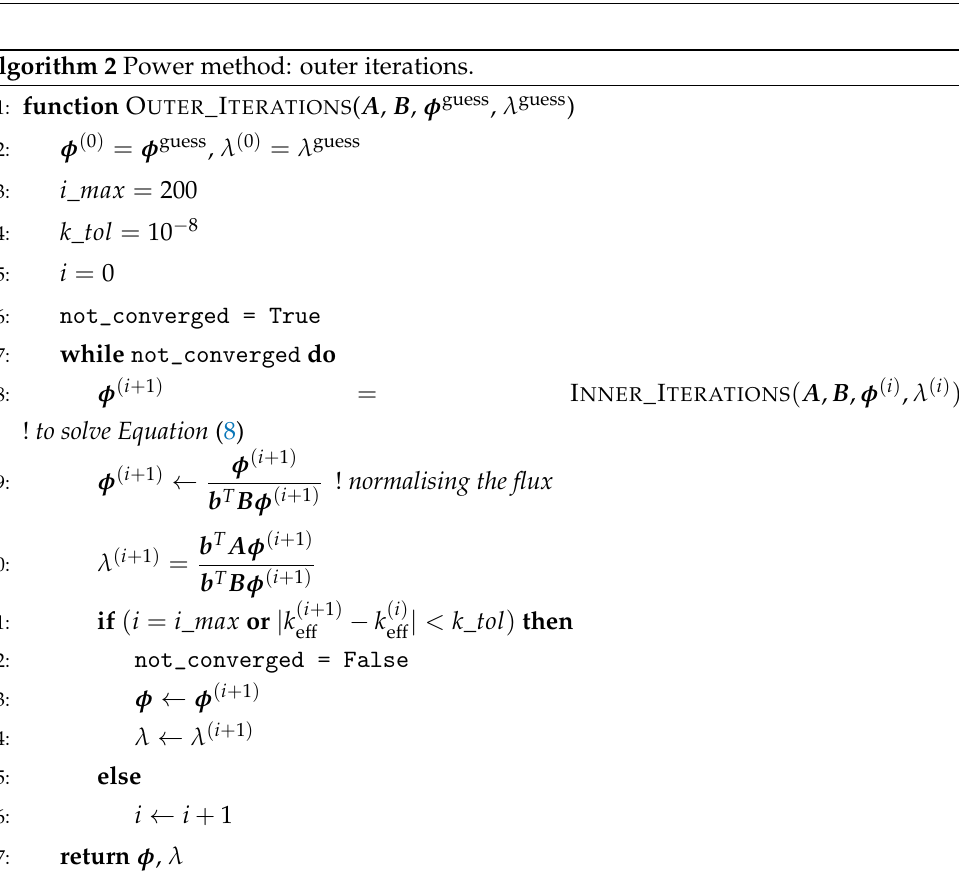
Algorithm 2 Power method: outer